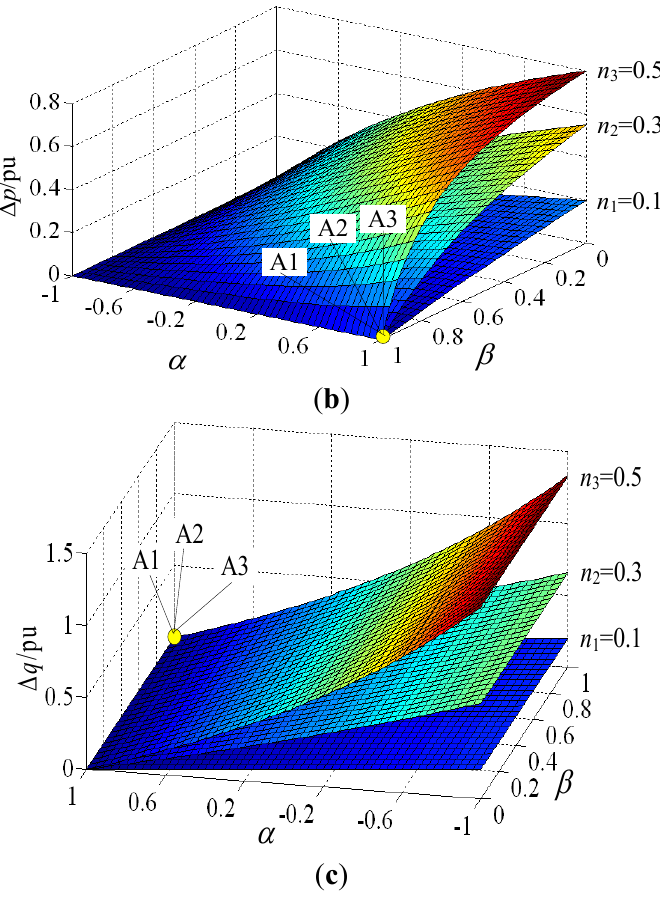
Figure 2. Three-dimensional meshes of current total harmonic distortion and power fluctuation magnitudes: ( a ) Current THD; ( b ) Active Power Fluctuation and ( c ) Reactive Power